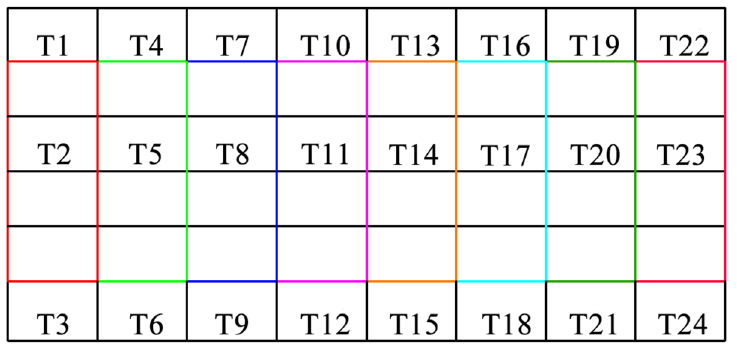
Figure 20. The observation area of the deck .